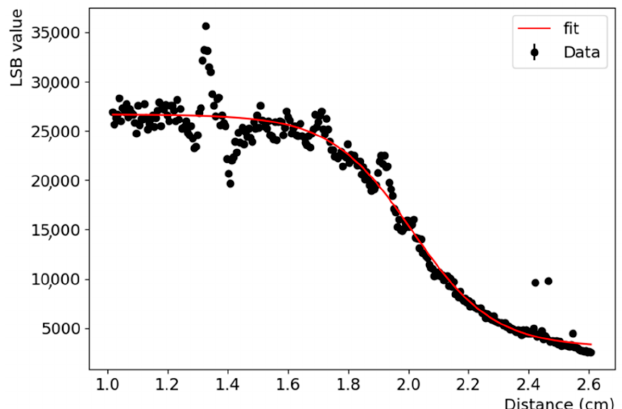
Figure 10. Edge response profile with the GEMPix for 40 kV X-rays obtained using a 2.5 cm-thick lead block. The red line represents a logistic function fit to the data. The signal fluctuations at around 1.4 cm are caused by the physical gap between the Timepix chips, which may lead to distortions of the electric field close to the edge. Other features, such as those around 1.7 and 1.9 cm, are due to imperfections in the detector that the equalization procedure cannot compensate for. These artefacts are most likely the result of radiation effects, as the detector was already used in several experiments with ionizing radiation.